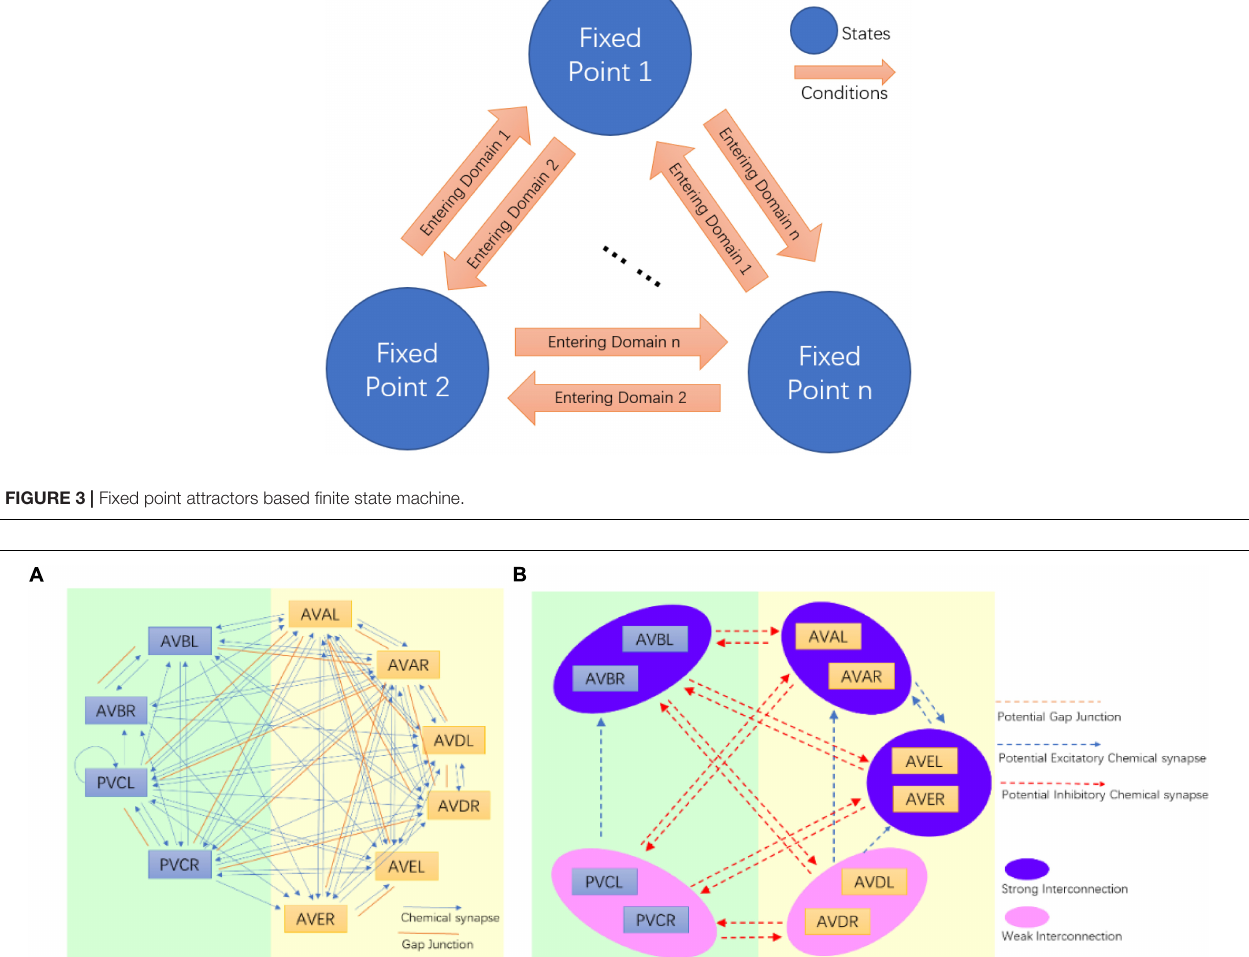
of PVCL/R and strong inhibitions of AVAL/R and AVEL/R. The fixed point 3 corresponds to no activations in any of the five pairs of